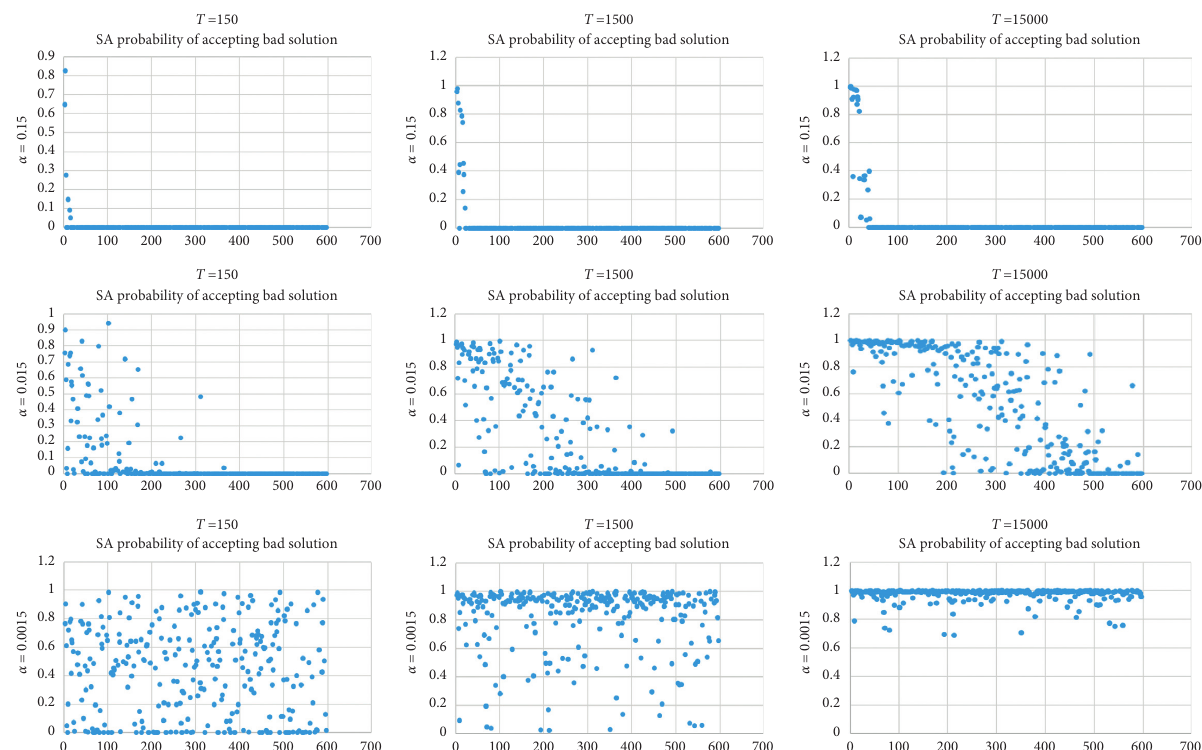
Figure 1: Selecting the best initial